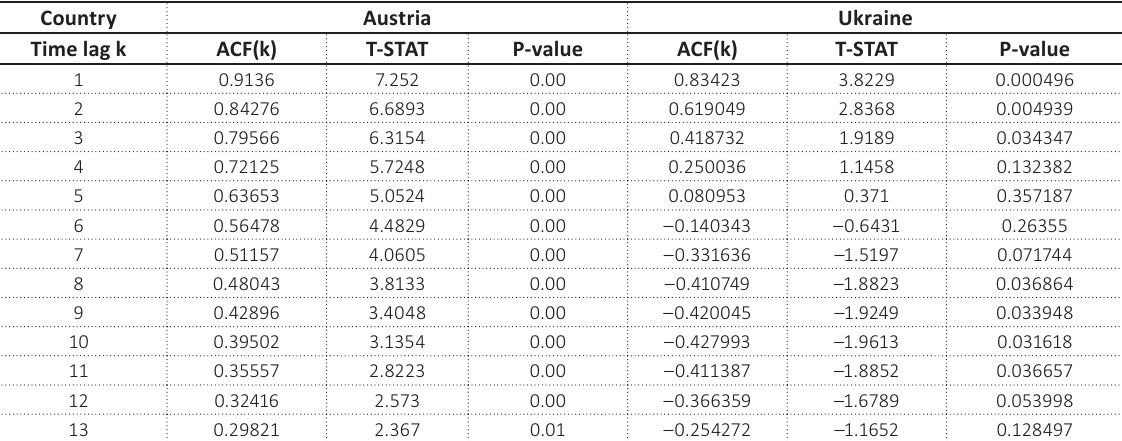
Table 6. Autocorrelation analysis for the case of Ukraine and Austria Country